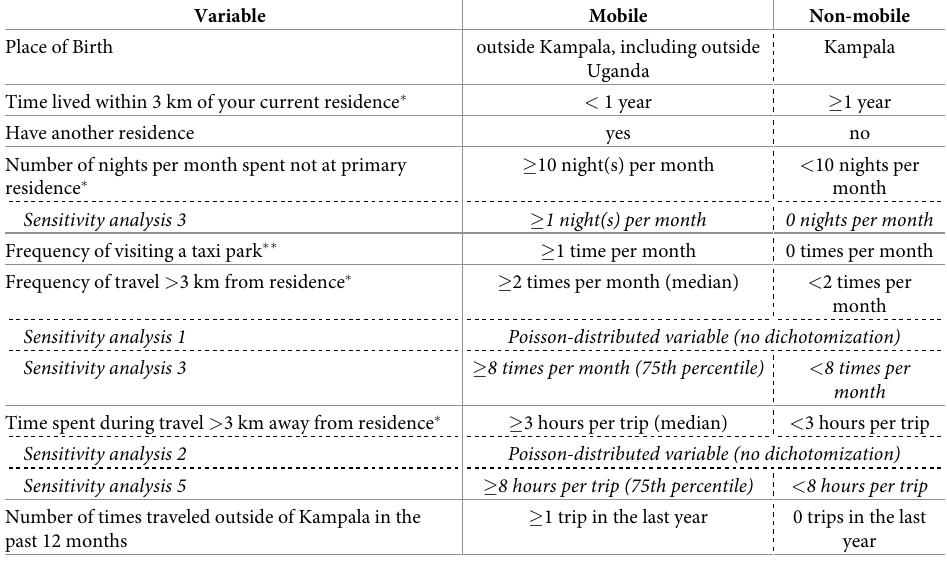
Table 1. Components of geographic